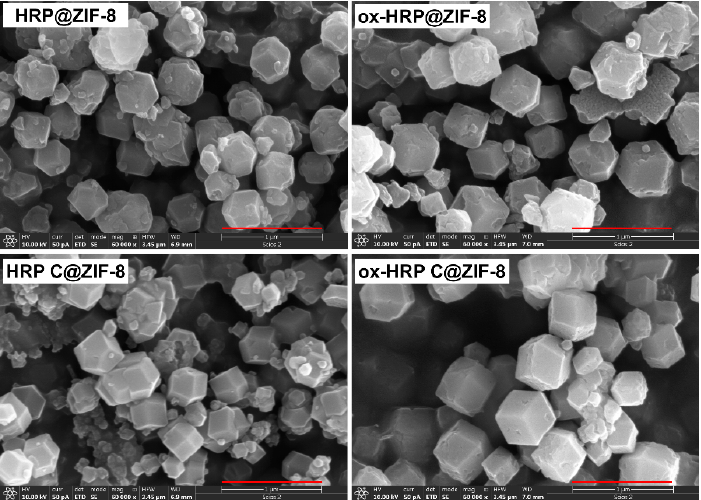
Figure A3. SEM images of bulk samples of four types of biocomposites (scale bar = 1 μ m).